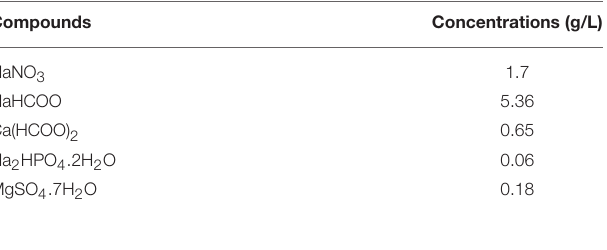
TABLE 1 | The feed composition for cultivation of ACDC. Compounds Concentrations (g/L)